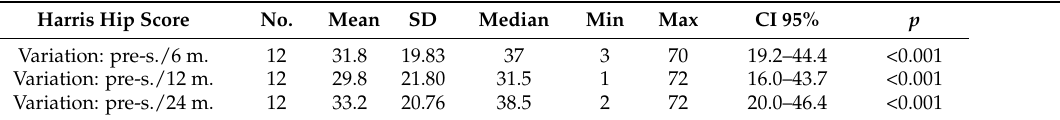
Table 5. Mean HHS values of second and third revisions in the different follow-up intervals and their comparison with the pre-surgical mean value.